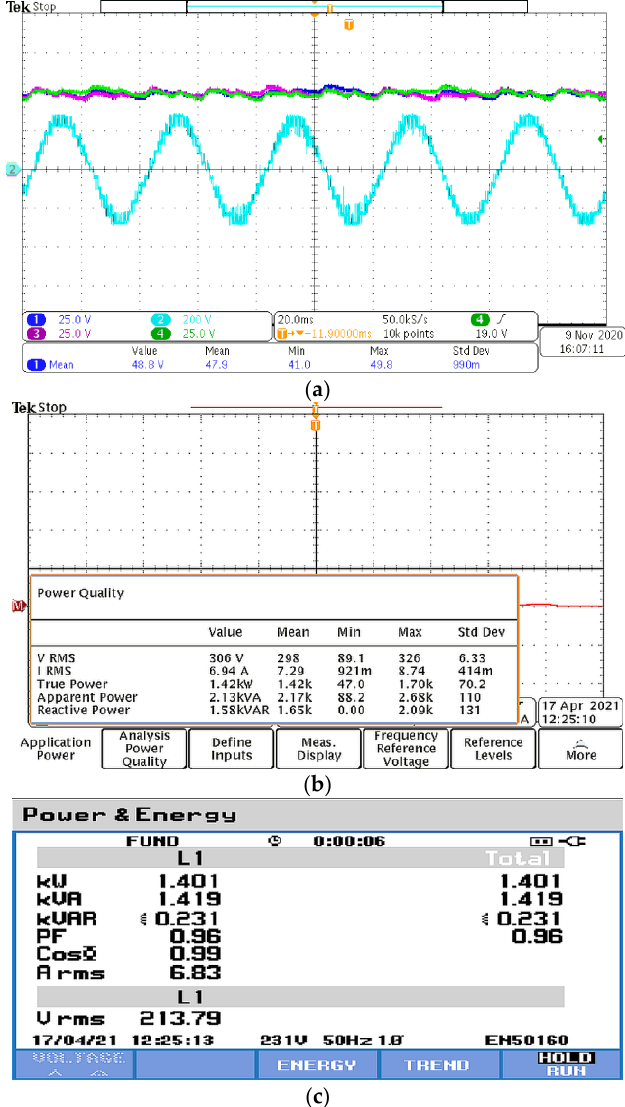
Figure 11. Experimental measured inverter input and out voltages and powers. ( a ) Capacitor bank voltages and the overall inverter output voltage ( b ) measured input power, ( c ) measured output power.